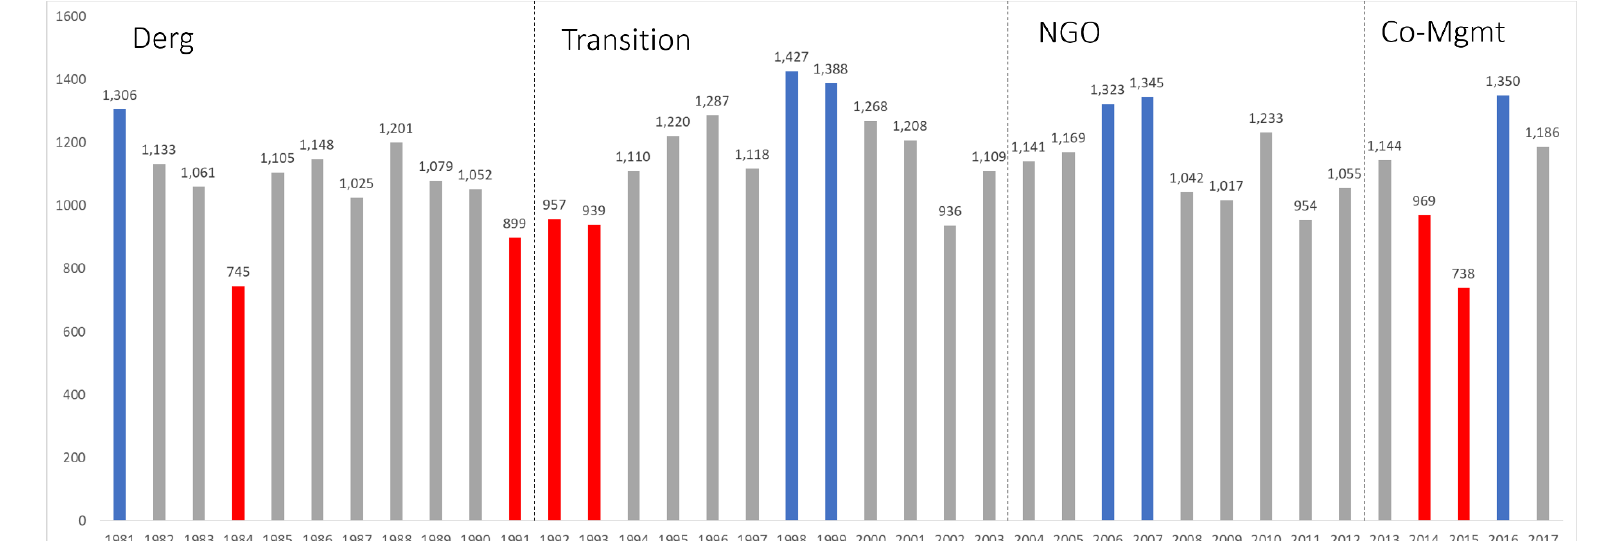
Fig. A1.5. Total annual precipitation (from CHIRPS). Wet years (in blue, precip > 1300 mm) and dry years (in red, precip < 1000 mm) were fairly evenly distributed throughout the study period except for the NGO